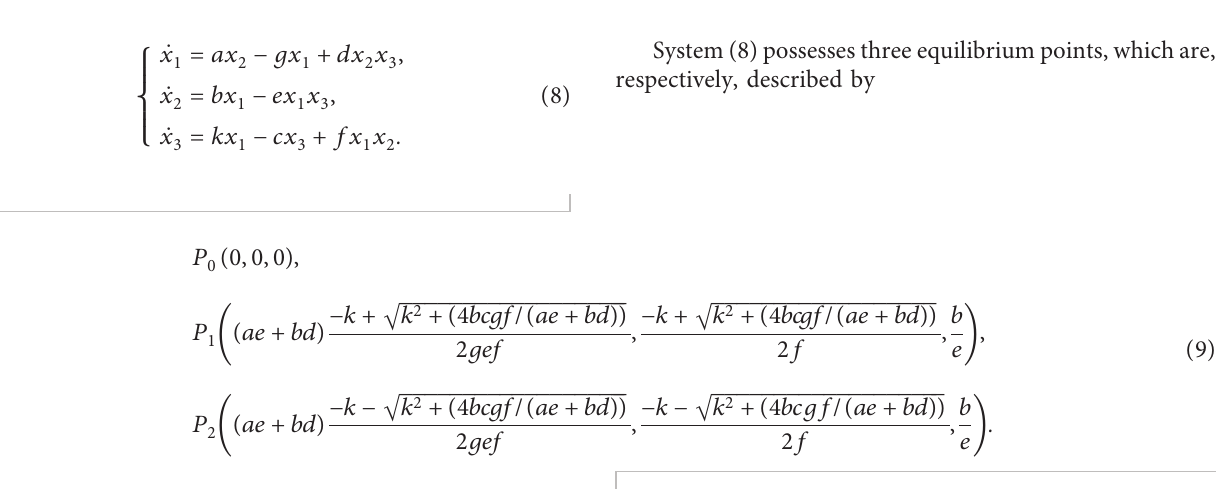
Figure 4: (a, b) Bifurcation diagram versus d ; (c) finite time Lyapunov exponent spectrum versus d